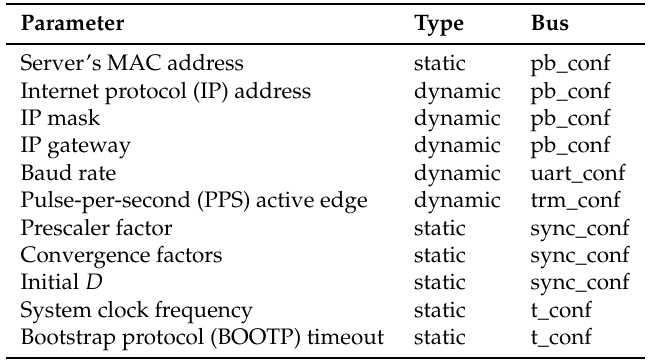
Table 3. Configuration parameters stored in the configuration